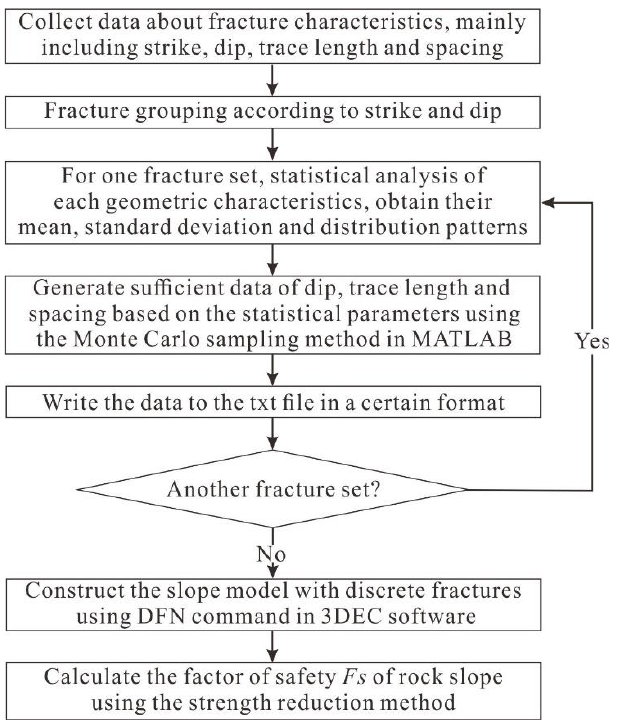
Figure 1. Flowchart of the DFN model employed in 3DEC software.